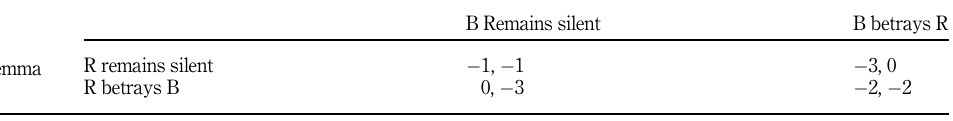
Table 2. Prisoner ’ s Dilemma payoff matrix